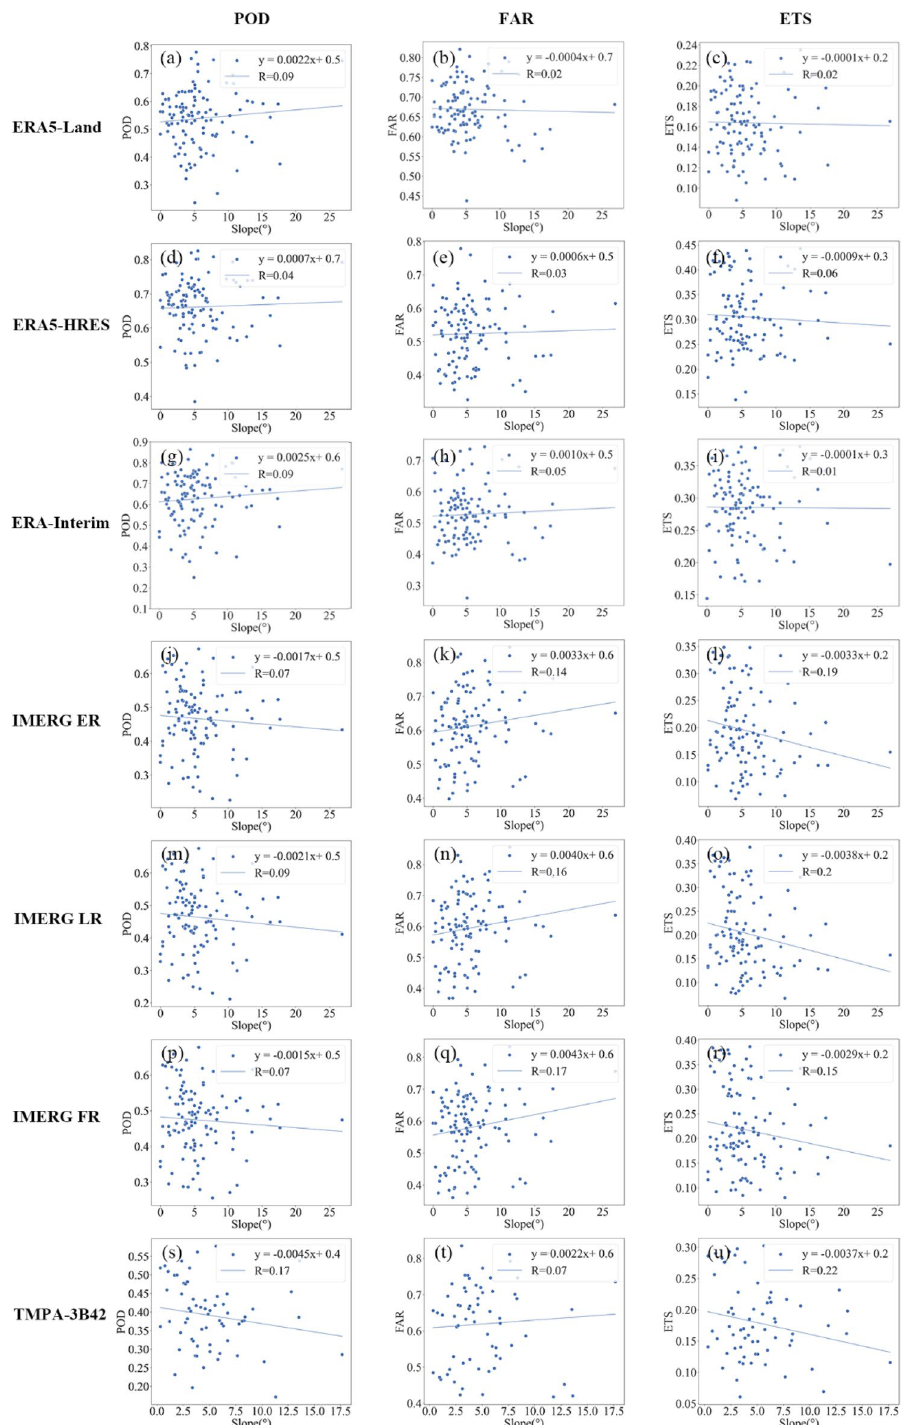
Figure 17. Changes in detection metrics with slopes. The subplots are POD for ( a ) ERA5-Land, ( d ) ERA5- HRES, ( g ) ERA-Interim, ( j ) IMERG ER, ( m ) IMERG LR, ( p ) IMERG FR, ( s ) TMPA-3B42; FAR for ( b ) ERA5- Land, ( e ) ERA5-HRES, ( h ) ERA-Interim, ( j ) IMERG ER, ( n ) IMERG LR, ( q ) IMERG FR, ( t ) TMPA-3B42; and ETS for ( c ) ERA5-Land, ( f ) ERA5-HRES, ( i ) ERA-Interim, ( l ) IMERG ER, ( o ) IMERG LR, ( r ) IMERG FR, ( u )